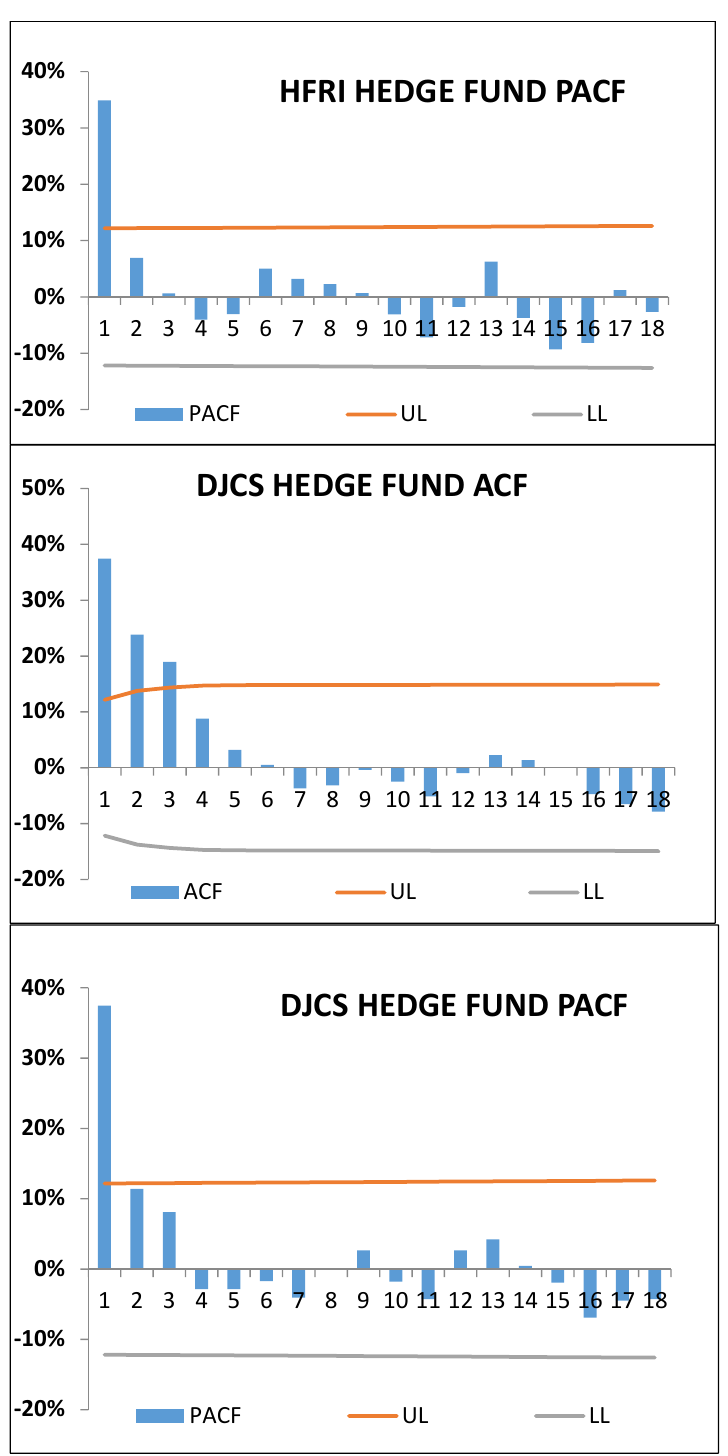
Figure 14. ACF and PACF plot for hedge funds. Source: authors.